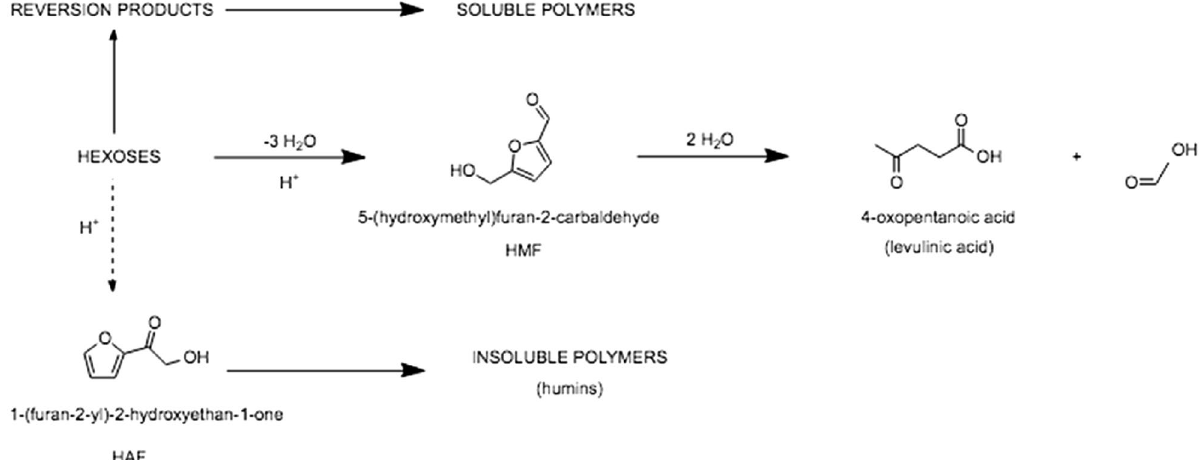
Figure 1. General pathways for the degradation of hexoses in water, catalysed by acids; variables such as concentration, temperature and use of co-solvent need to be strictly controlled to increase HMF selectivity and high hexoses conversion